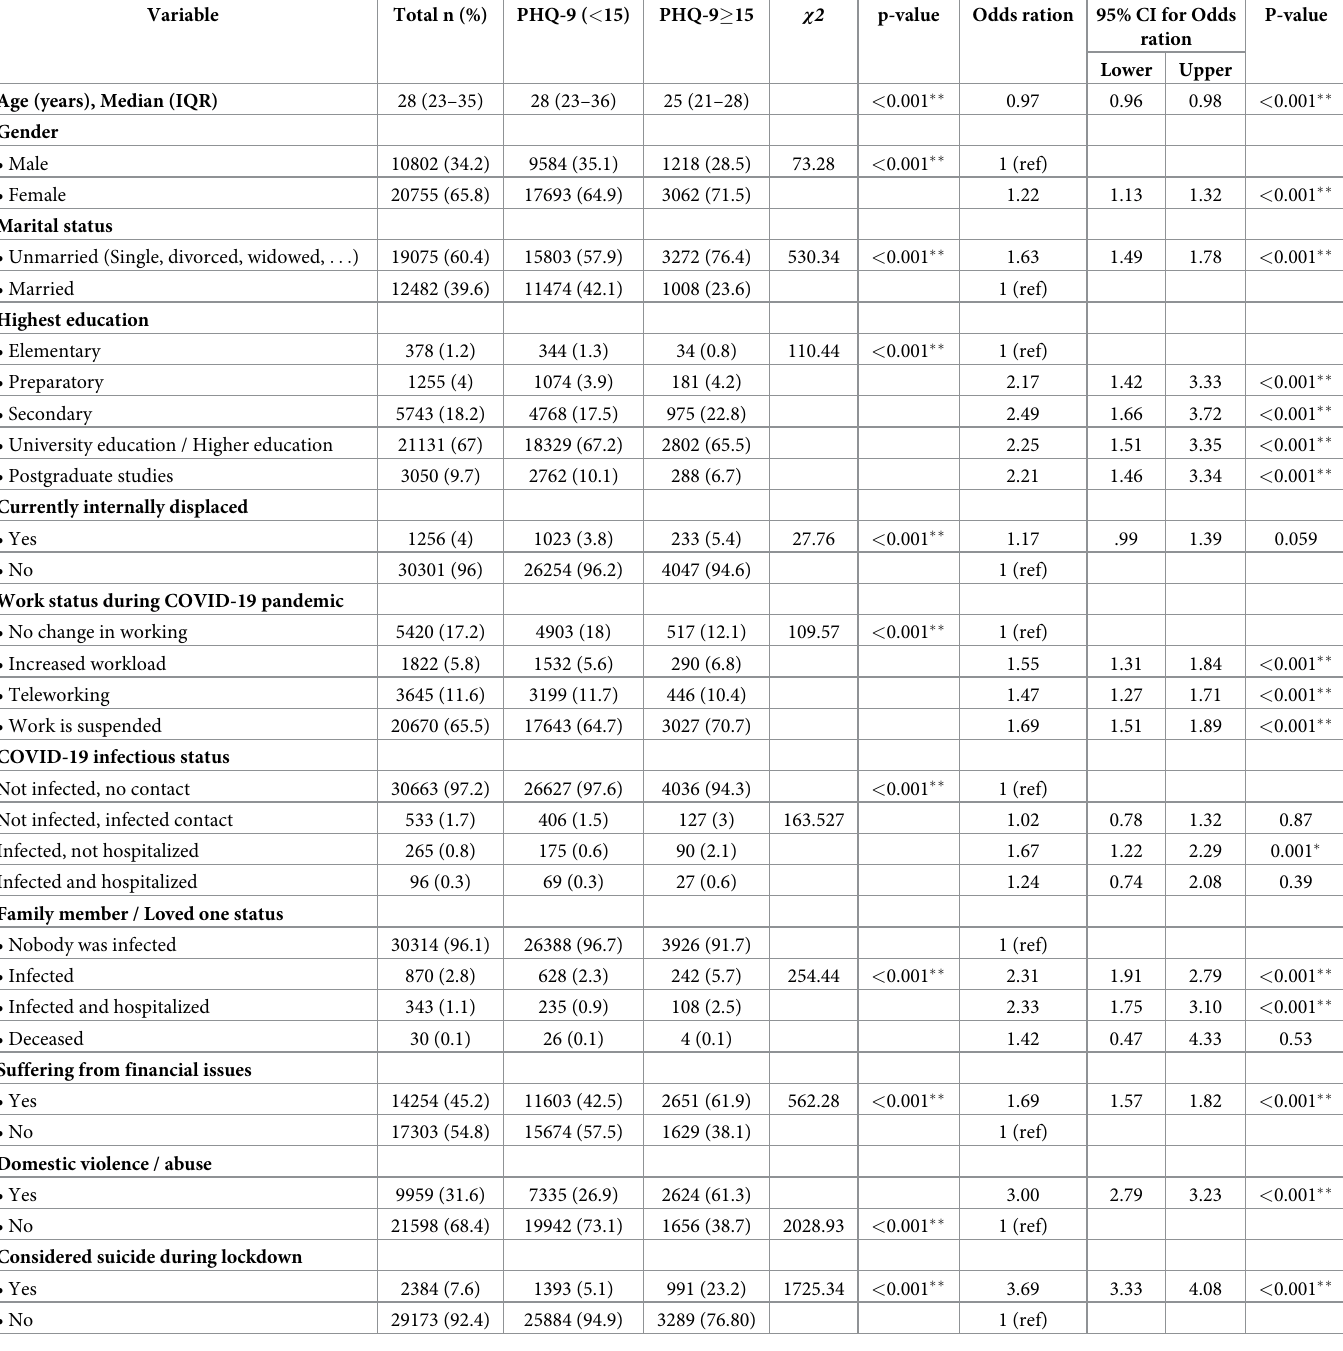
Table 3. Bivariate and multivariate binomial logistic regression analysis of depressive symptoms (PHQ-9 � 15).